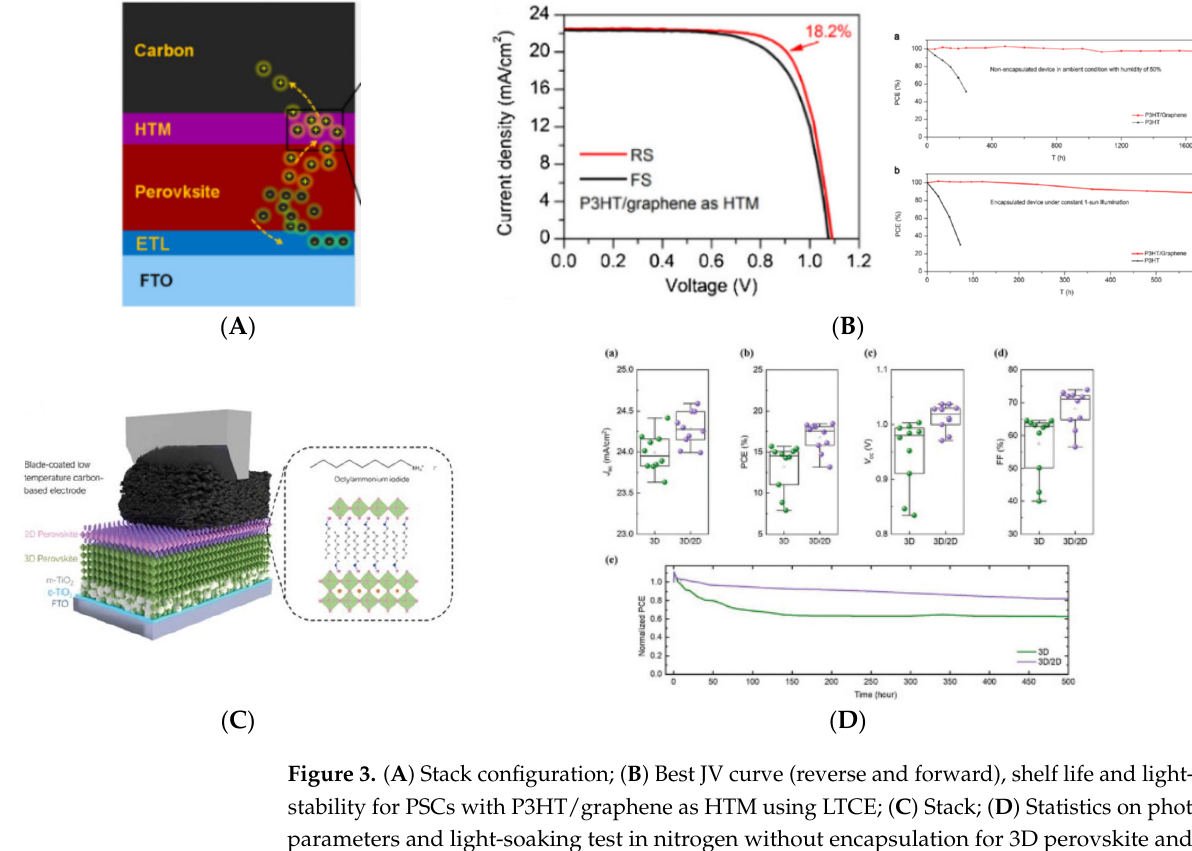
Figure 3. ( A ) Stack configuration; ( B ) Best JV curve (reverse and forward), shelf life and light-soaking stability for PSCs with P3HT/graphene as HTM using LTCE; ( C ) Stack; ( D ) Statistics on photovoltaic parameters and light-soaking test in nitrogen without encapsulation for 3D perovskite and 3D/2D perovskite carbon-based devices. All images are reprinted with permission from reference [76] (Figure 3A,B) and reference [92] (Figure 3C,D).